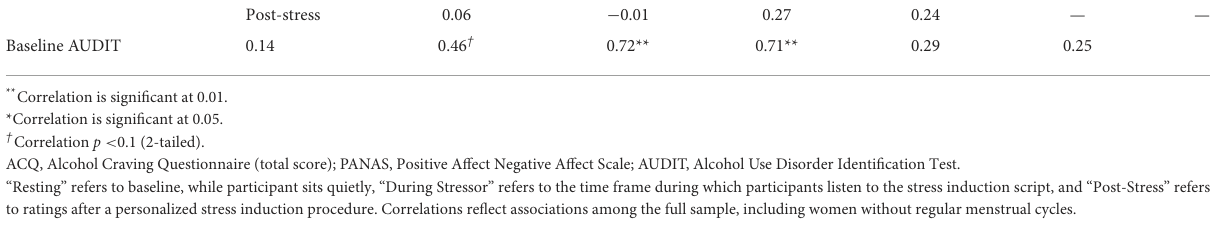
TABLE 3 Aim 2 model